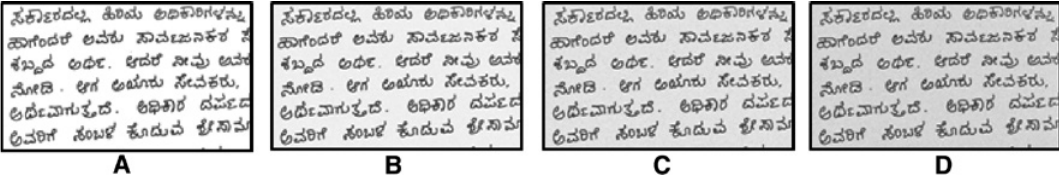
Table 3: Recognition Accuracies of Six Classifiers and Their Corresponding Ranks Using 12 Different Datasets Before Performing HSA (Ranks in Parentheses Are Used for Performing Friedman Test).